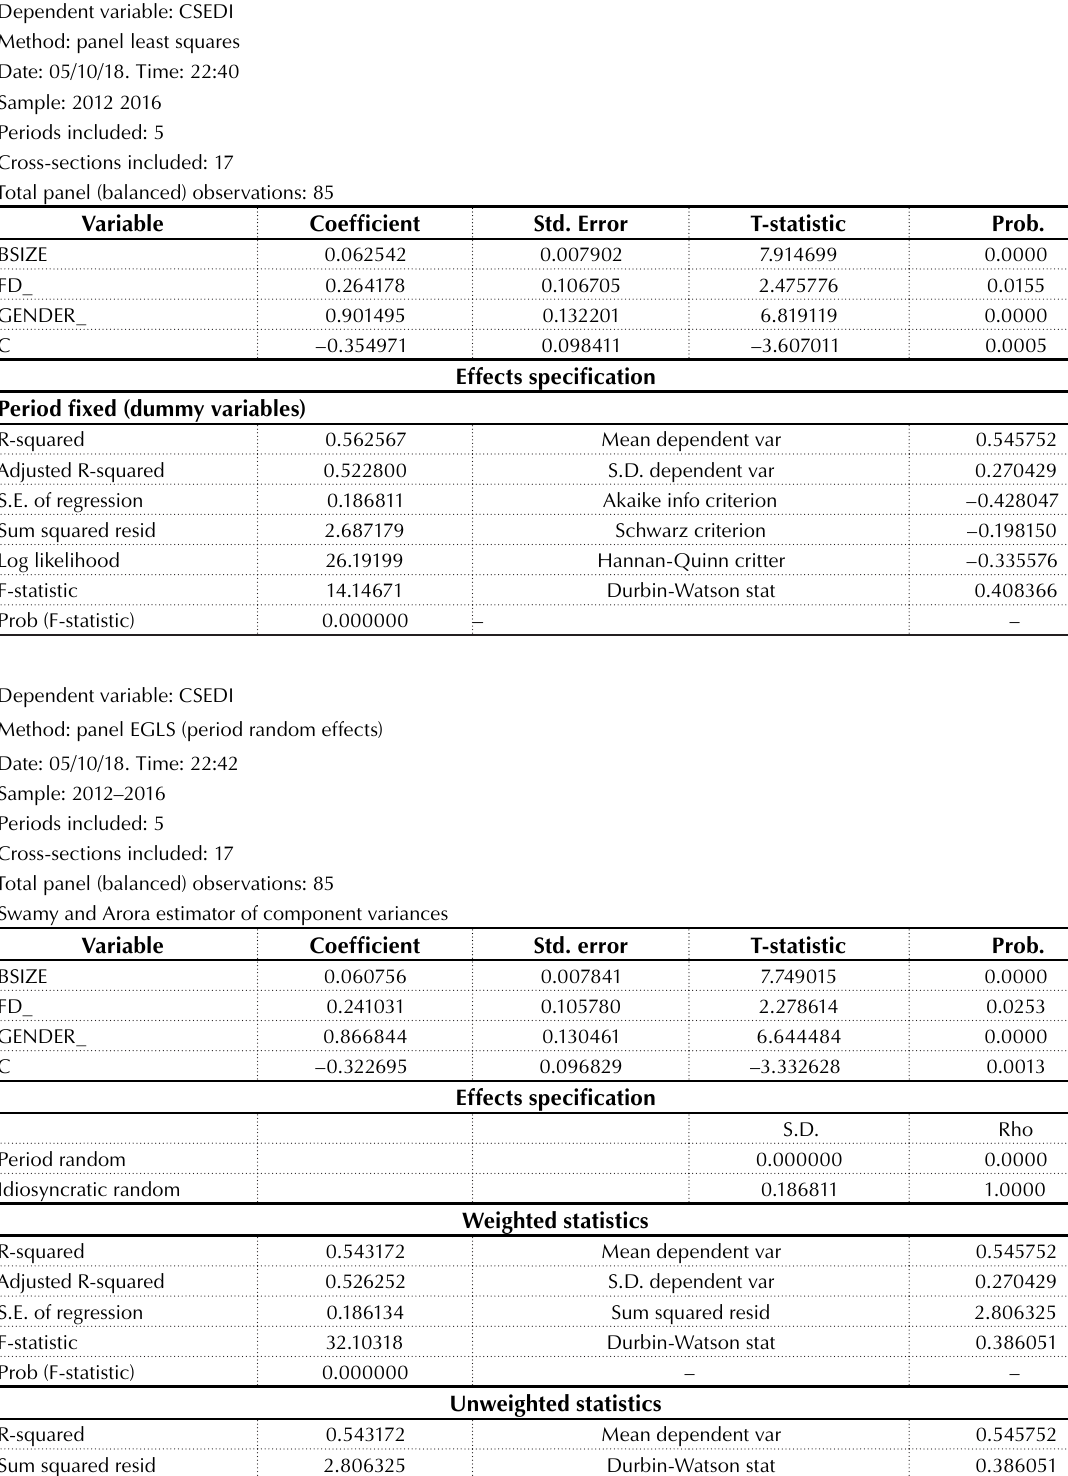
Table A1. Regression result for panel